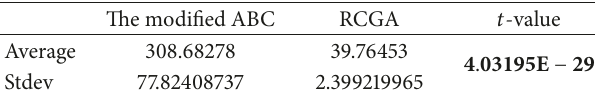
Table 4: The 𝑡 -value for MABC and RCGA in 49 degrees of freedom is significant at a QoS level of significance by two-tailed 𝑡 -test. The modified ABC RCGA 𝑡 -value Average